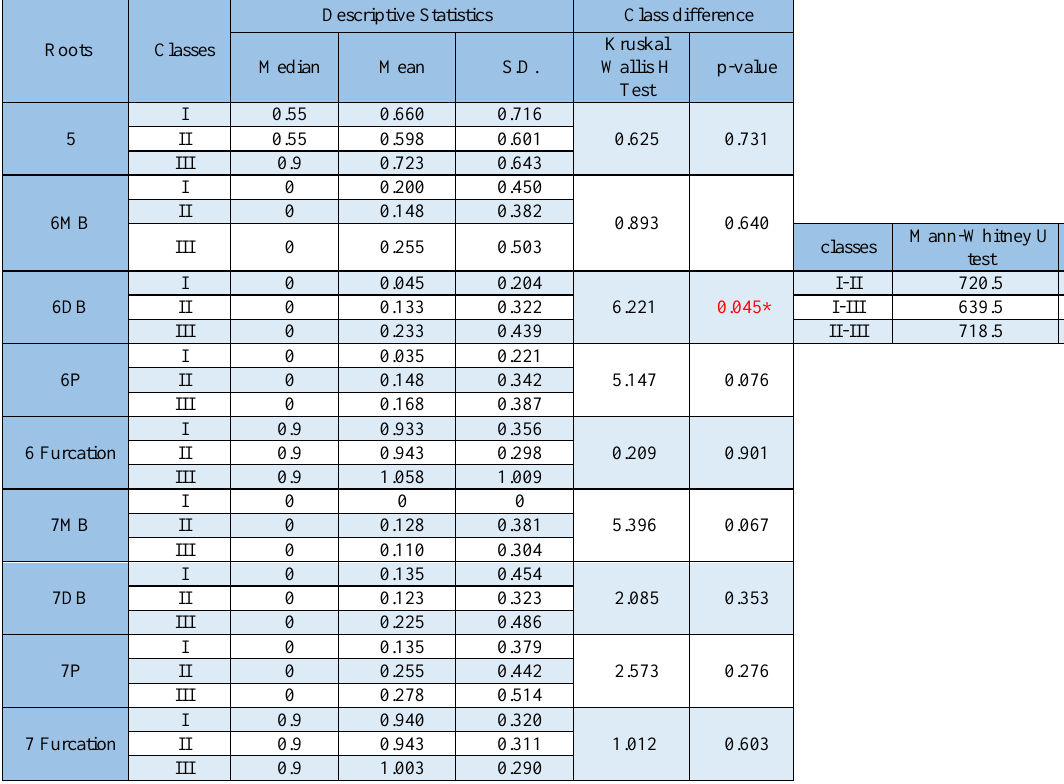
Table 2: Thickness (mm) of the sinus floor above root apices on CBCT according to classes